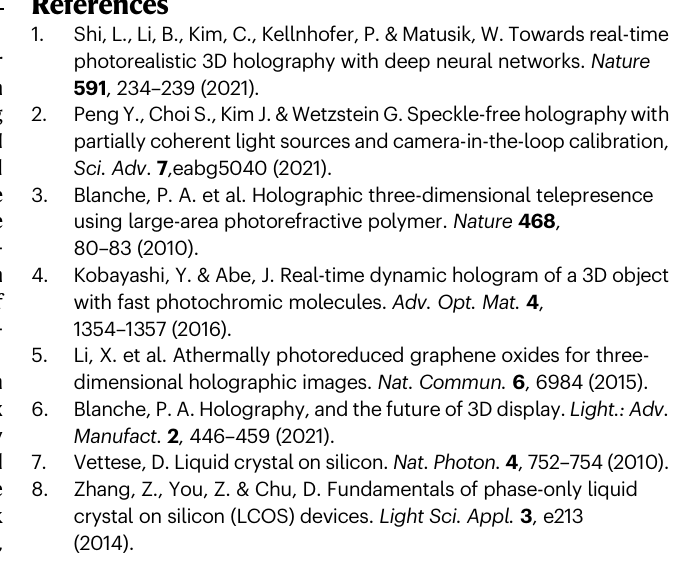
Fig. 10| Qualityofreconstructionsfrombinary holograms. a Exemplary frames of a reconstructed movie from CGHs calculated by the FPGA processor. The top rowshowsthebinaryCGHsofthemovingdinosaur,andthebottomrowshowsthe corresponding reconstructed images. b CGHs computed with alternative algo- rithms and respective reconstructed images. Two frames of an animated dinosaur are computed by a direct computation of Eq. (5) (Ground-truth); the proposed methodandwavefrontrecordingplane(WRP)method.Thesameinputobjectdata and direct fi nal amplitude binarization were used for fair